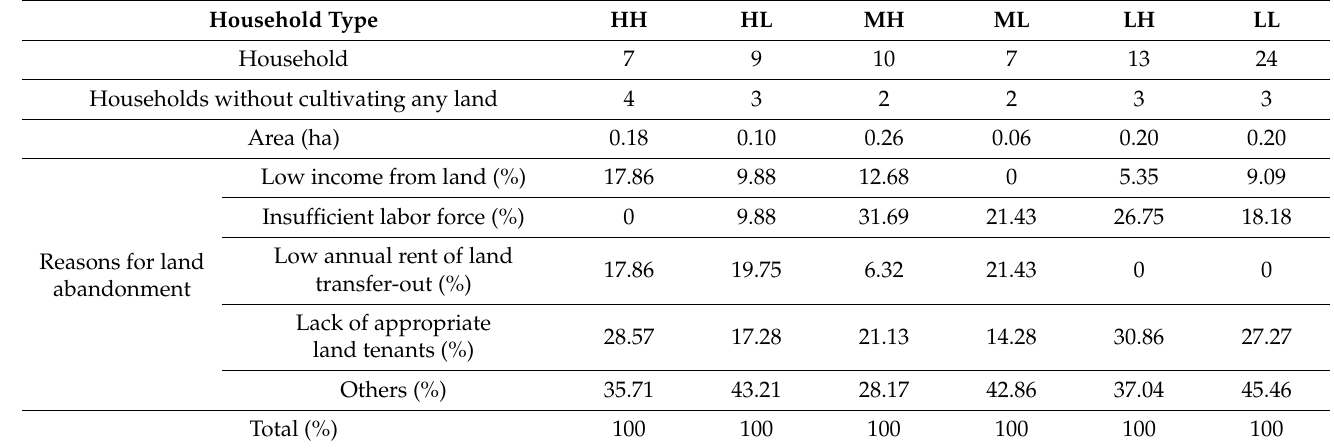
Table 12. Land abandonment